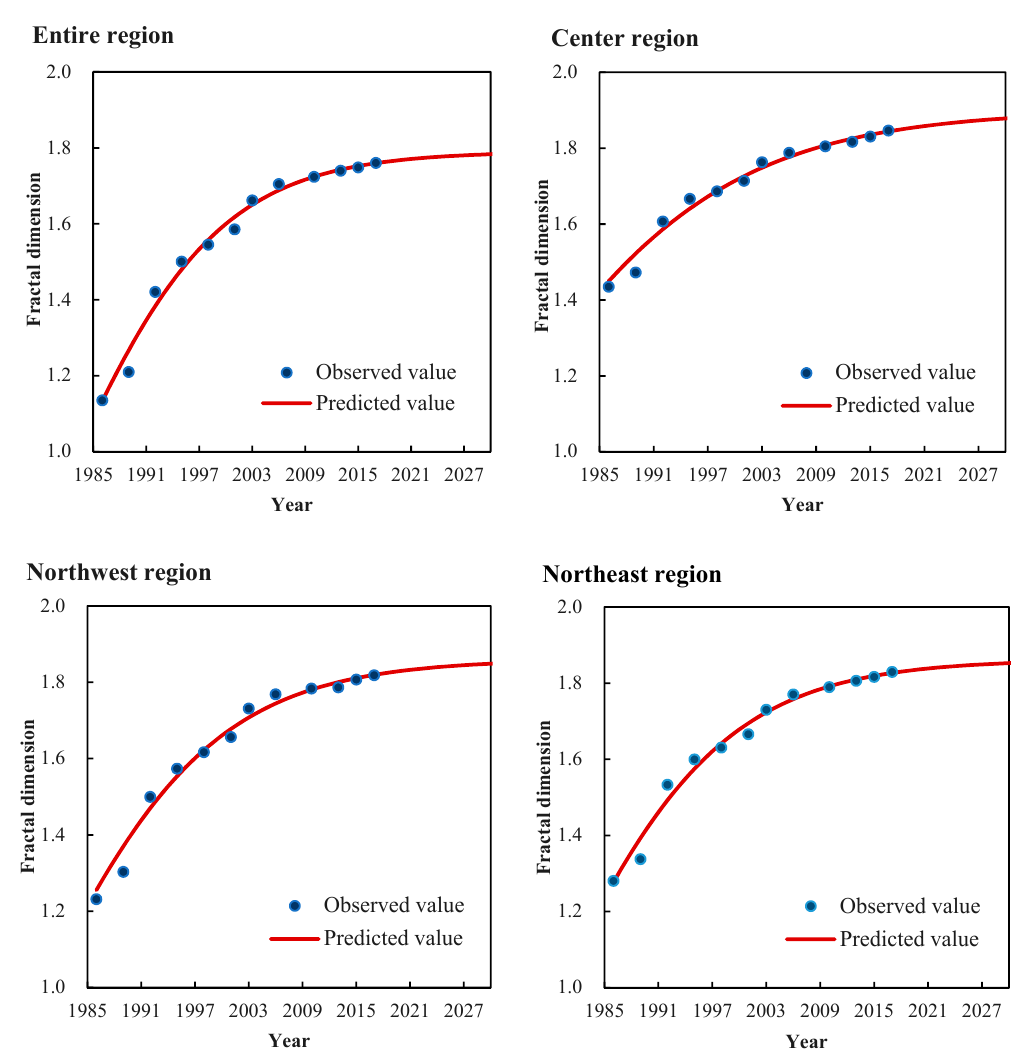
Figure 3. The logistic patterns of fractal dimension growth of the four study regions, 1986–2017.